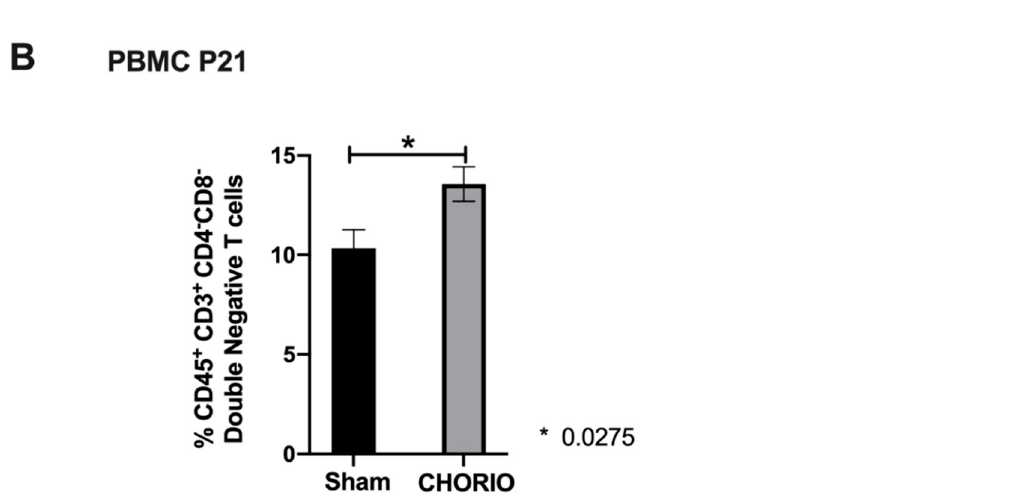
Figure 7. CHORIO induced increase in peripheral blood CD45 + CD3 + CD4 − CD8 − T cells at P21. Representative gating strategy for PBMC analysis from a CHORIO pup at P21 ( A ). FMO controls were utilized for all fluorophores in the panel. CHORIO resulted in a significant increase in the percentage of CD45 + CD3 + CD4 − CD8 − T cells from P21 pups compared with sham (* p = 0.0275, normally distributed, Welch’s t -test, mean ± SEM), ( B ).